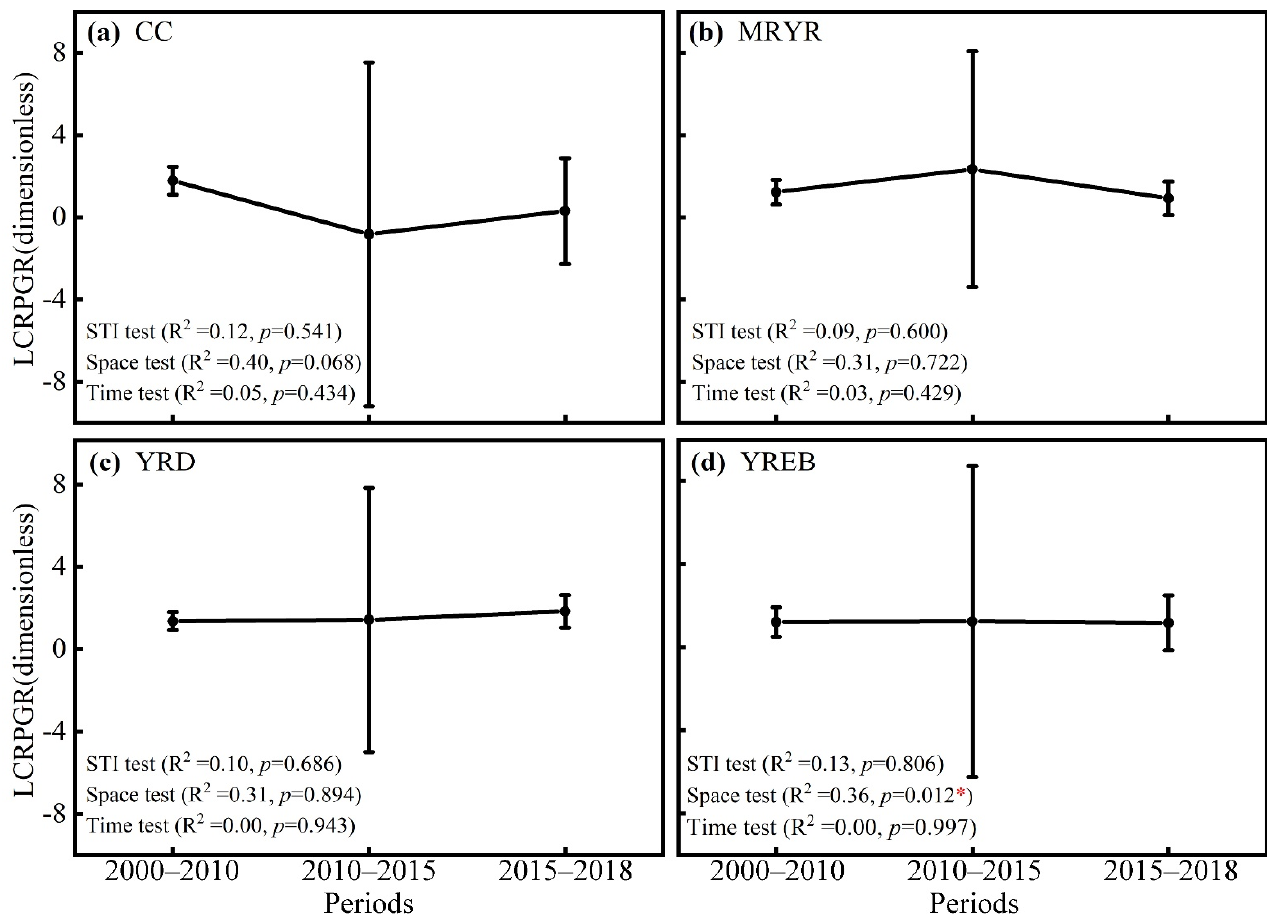
Figure 5. STI test results for LCRPGR across prefecture-level cities in ( a ) CC, ( b ) the MRYR, ( c ) the YRD, and ( d ) the YREB over the entire study period (2000–2018) (mean ± SD across all prefecture-level cities). ⁎ Significance level of 0.05.